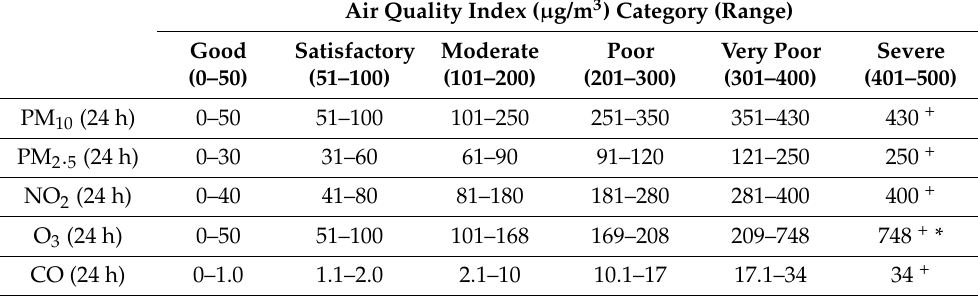
Table 14. Air quality index computation table.